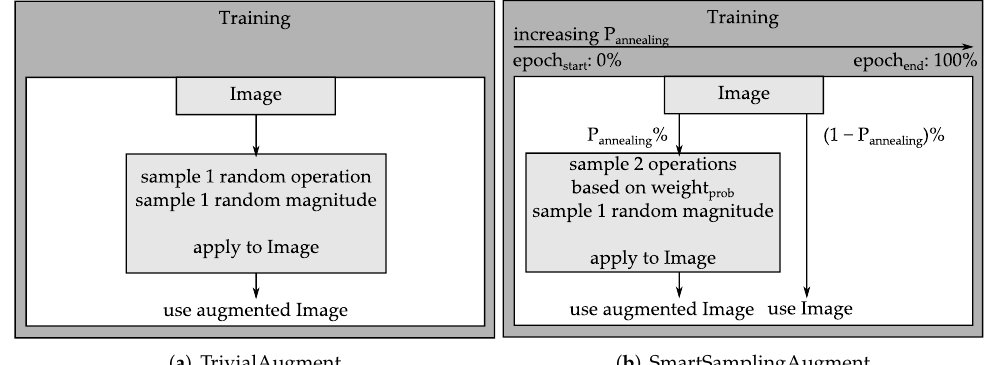
Figure 2. Comparison of TrivialAugment and